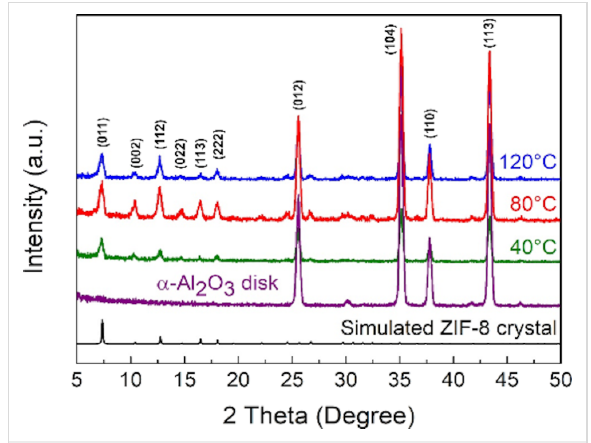
Figure 2: XRD patterns of simulated ZIF-8 crystal, porous α -Al 2 O 3 disk, and ZIF-8 membranes fabricated at 40, 80, and 120 °C.